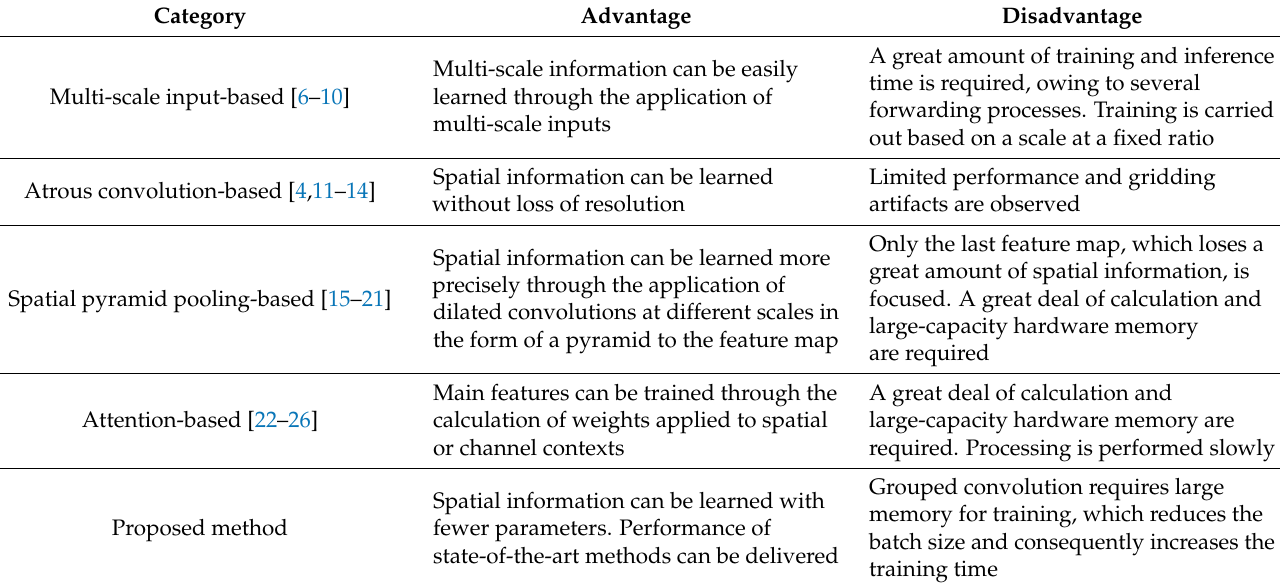
Table 1. Summarized comparisons of the proposed and previous works on semantic